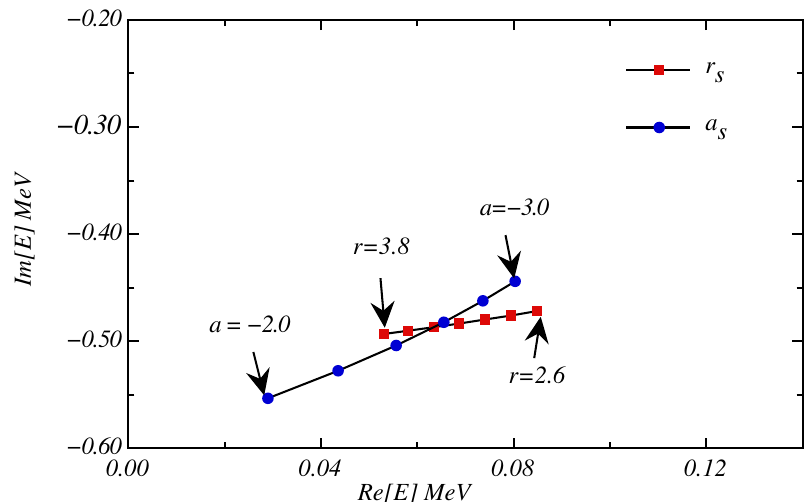
Figure 3: Variation in the position of the Λ nn pole as one varies either the singlet scattering length a (fm) or the effective range r (fm). The starting interaction is a s s Yamaguchi potential based upon the Nijmegen Model D [ 11 ] , with a scaling strength factor s = 1.1.